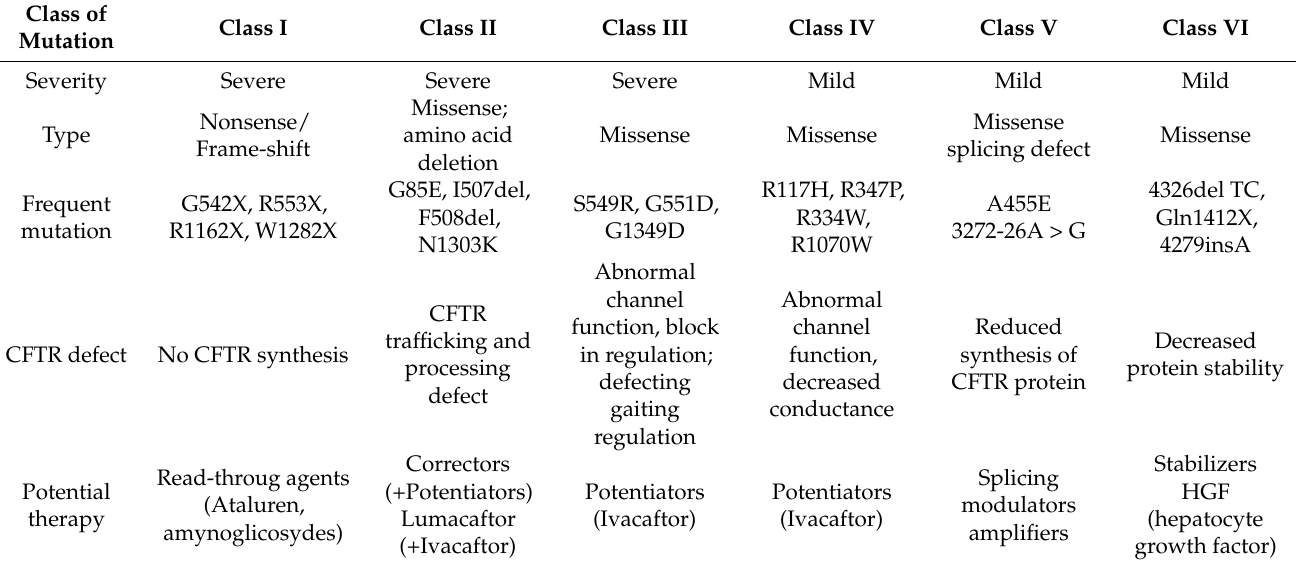
Table 2. Class of CFTR gene mutations: genotype-phenotype correlations